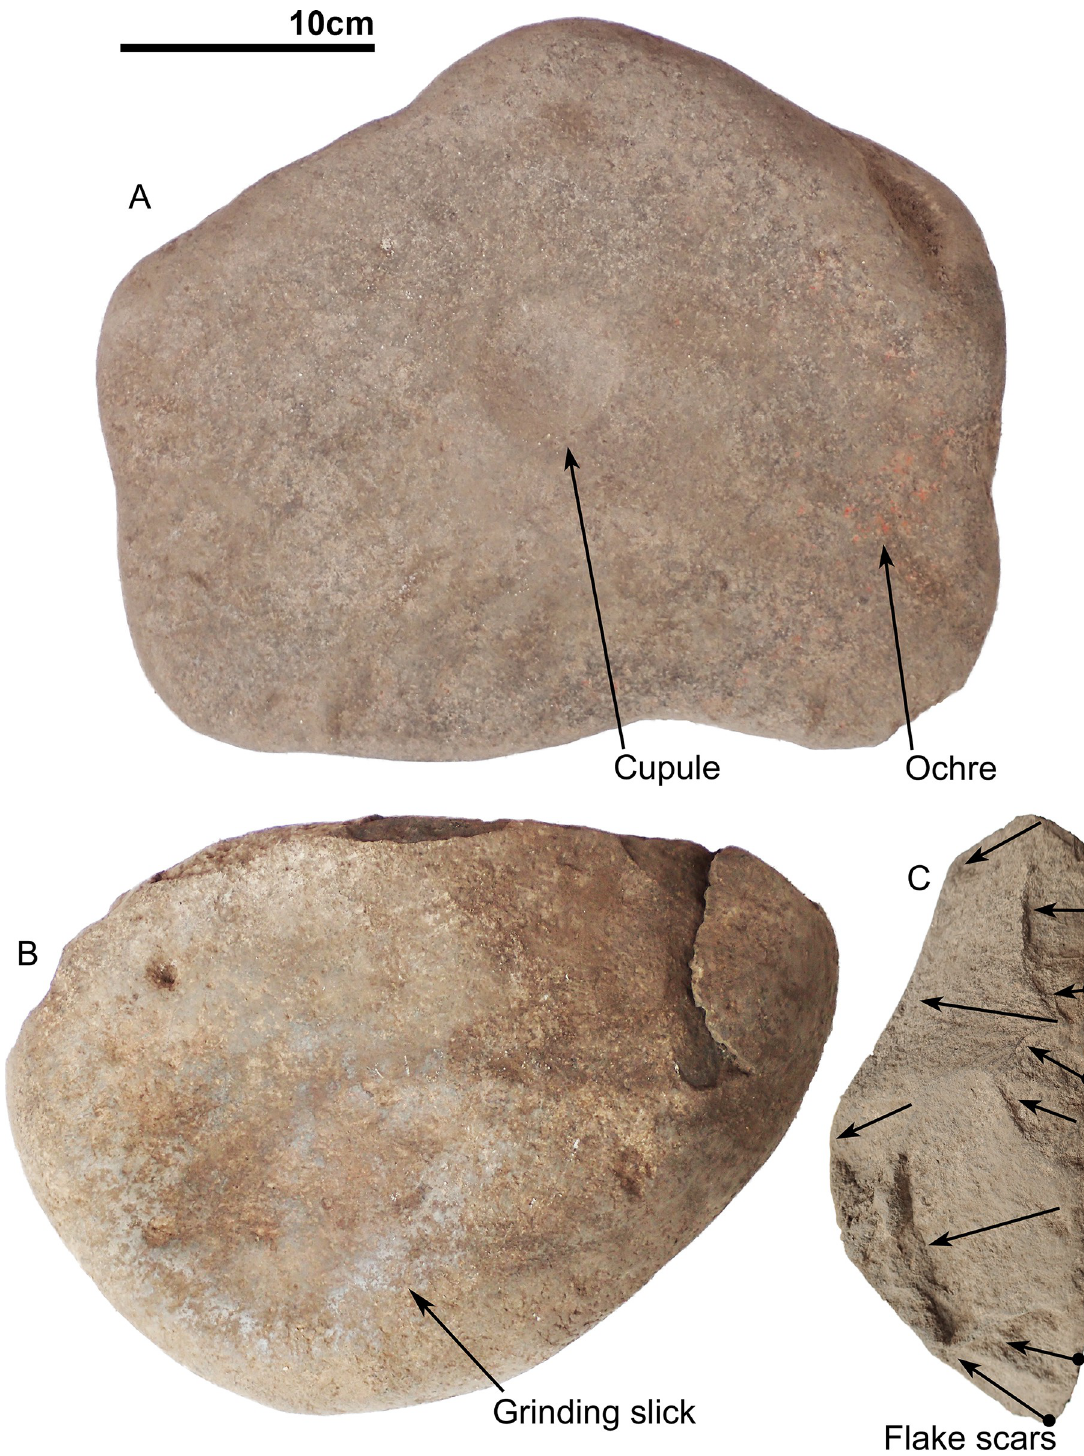
Fig 9. Cobbles from Tron Bon Lei burials. A) Ochred cobble with a regular cupule in the centre, that was placed directly on top of burial E16b; B) Grindstone associated with burial DE B2; C) Flaked surface of a cobble associated with burial DE B2. See Fig 7 for location of these cobbles in DE